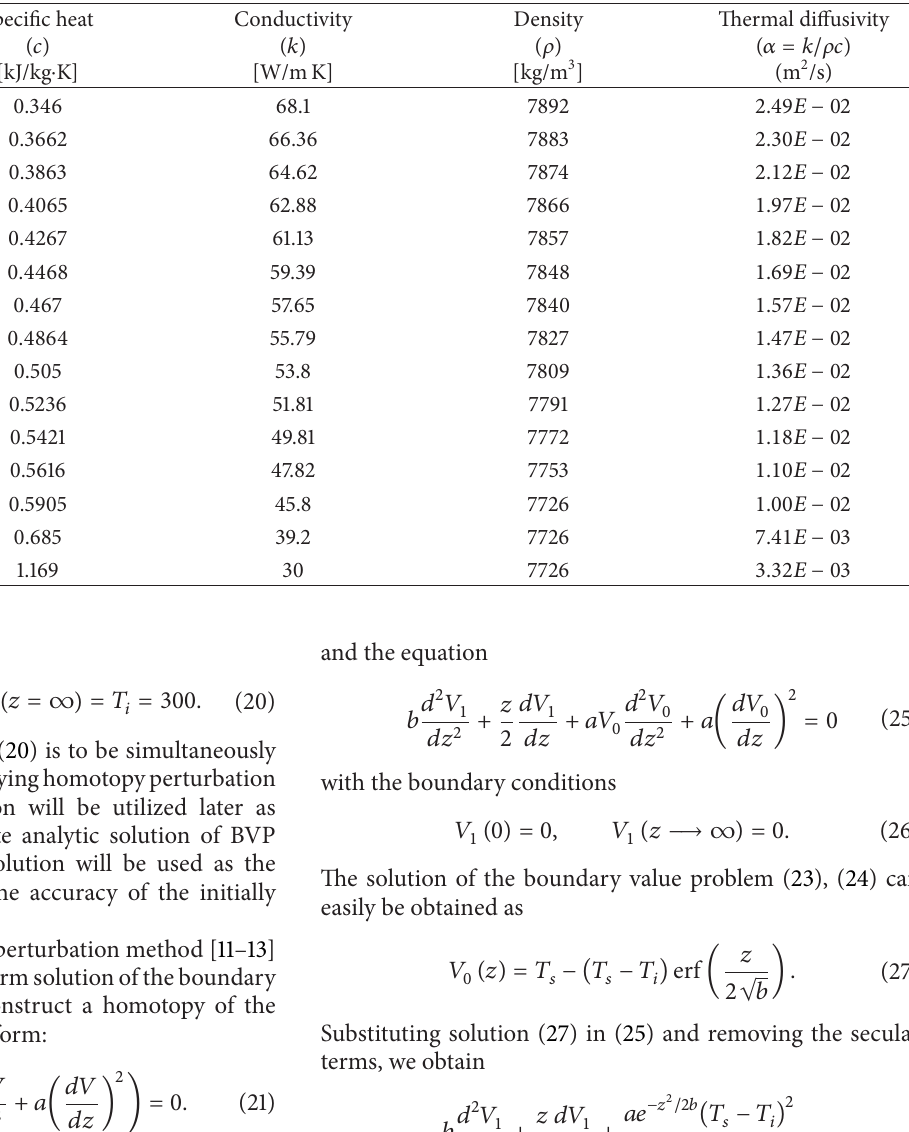
Table 2: Thermal properties of mild